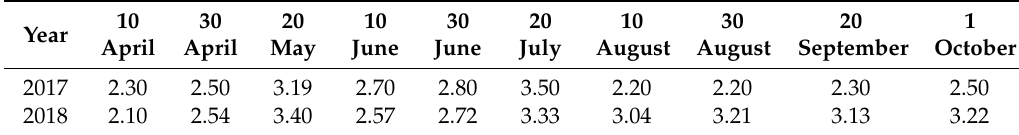
Table 2. Variance of lake electrical-conductivity (EC) values (dS m − 1 ).